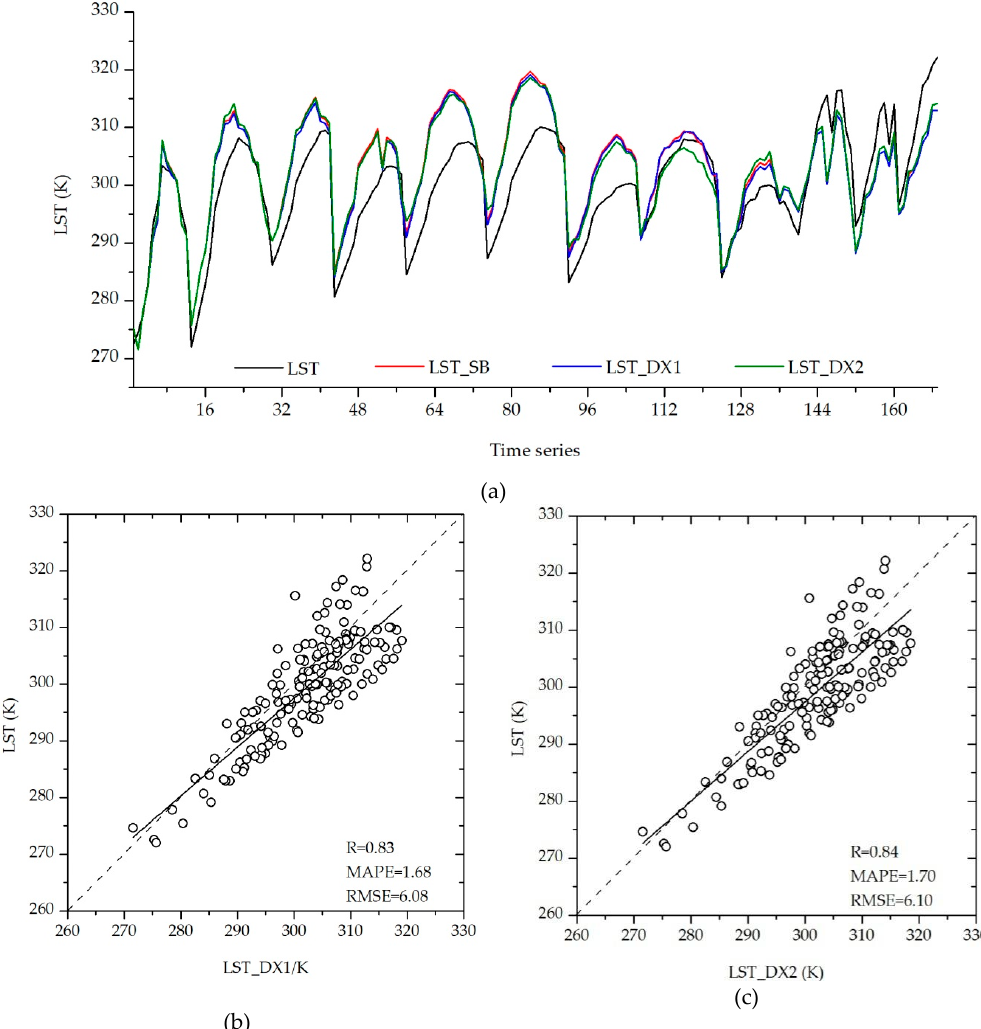
Figure 9 . Comparison of LST retrieved by different emissivity models and measured values; ( a ) is the time series, ( b ) is the LST results based on the DX1 emissivity model, and ( c ) is the LST results based on the DX2 emissivity model.